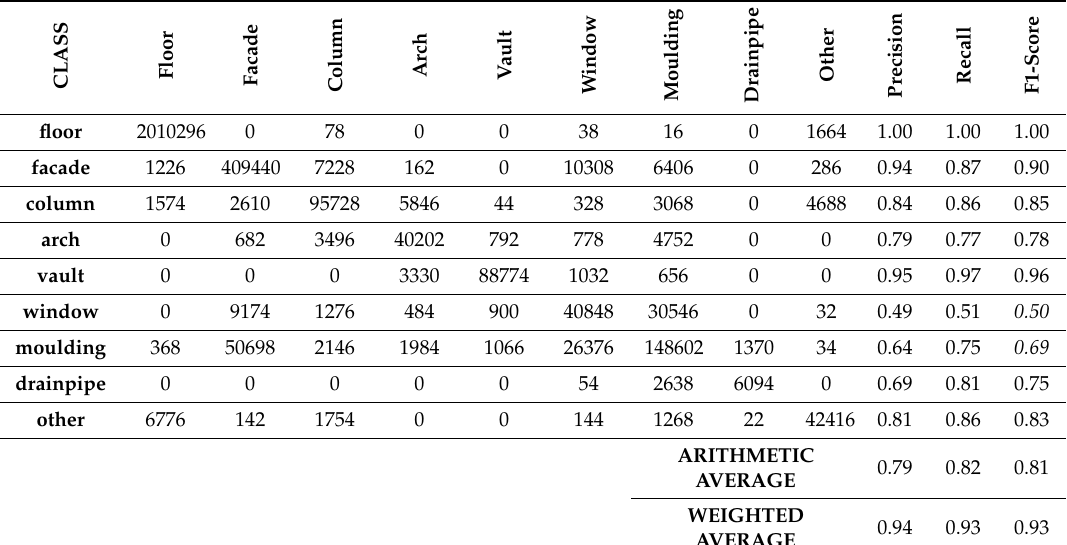
Table 7. Evaluation metrics: generalisation level #4, dataset F. The most critical F1 values are reported in italics ( window and moulding classes).